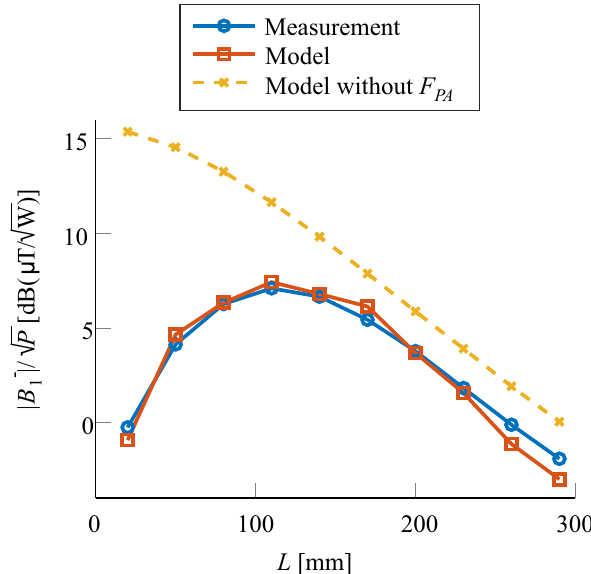
√ (cid:12) ( r ) (cid:12) (cid:12) / P versus coil distance L of the two-channel coil array of (cid:12) B − 1